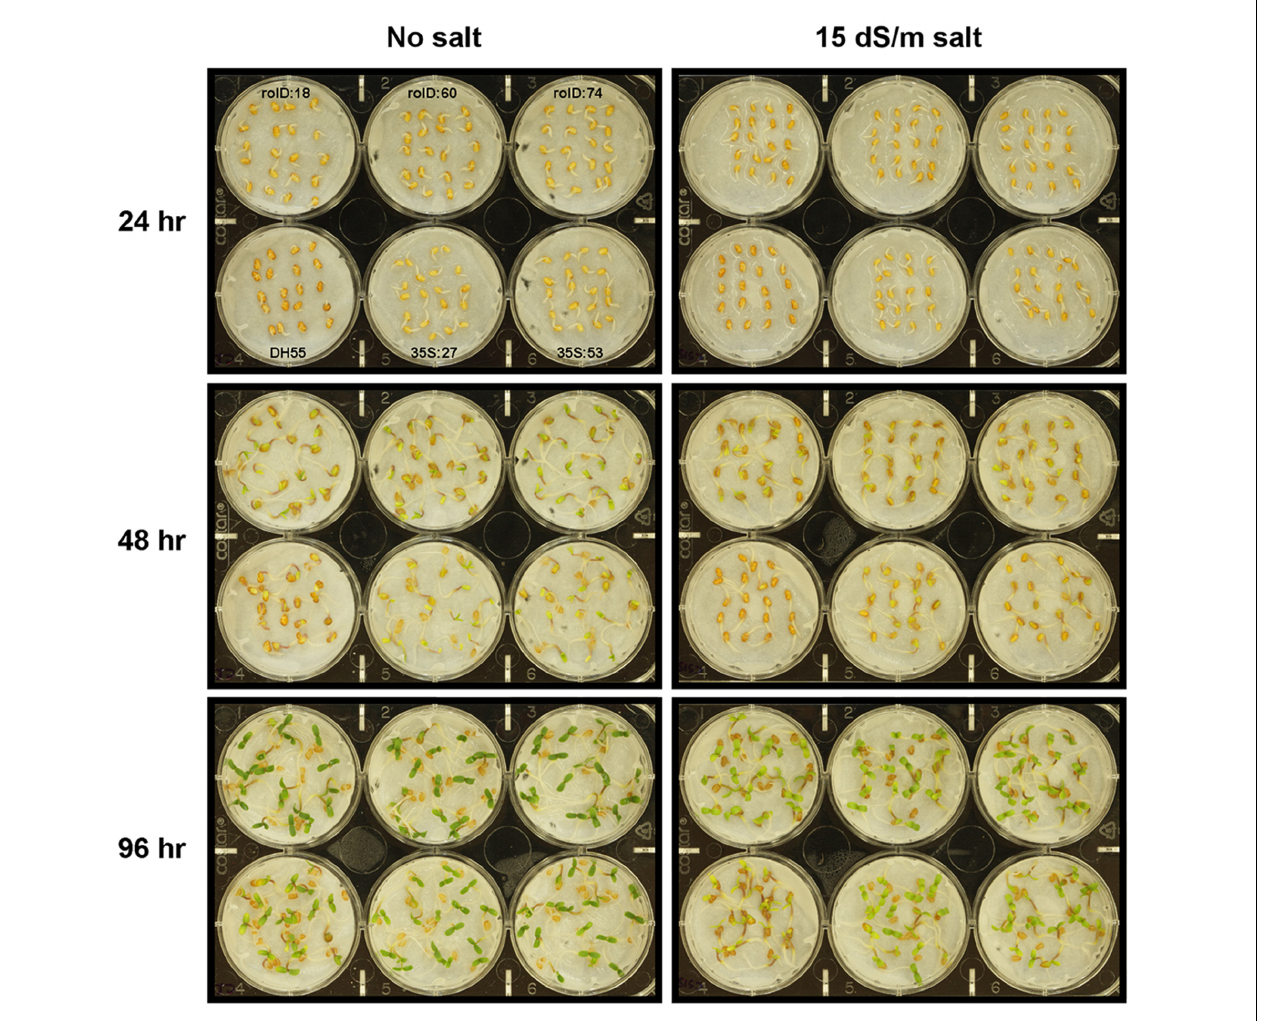
FIGURE 5 | Germination of camelina seeds in the absence of, or presence of, salt (15 dSm − 1 ). Lines tested include wild-type C. sativa DH55 or independent, single insert, homozygous transgenic lines expressing the acdS gene under the control of the root-specific rolD promoter or the constitutive CaMV 35S promoter. The grid in the top left panel applies to all panels in the